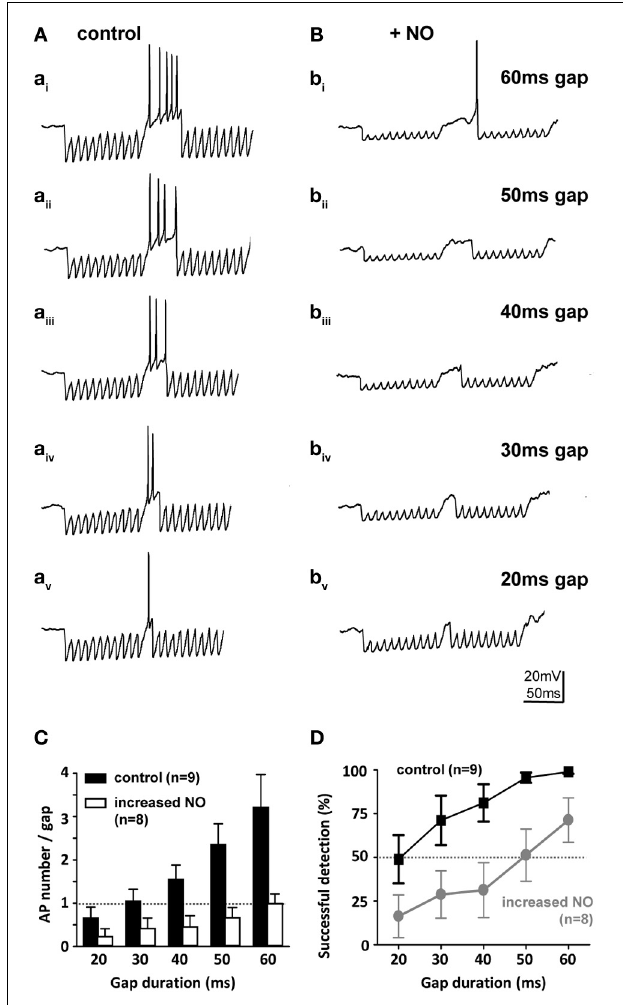
FIGURE 6 | NO suppresses IPSPs and offset firing without changing intrinsic action potential threshold. (A) Suppression of KCC2 causes synaptically-evoked IPSPs to be less hyperpolarizing. The grey bar indicates the voltage threshold for generating rebound action potentials ( − 80 . 4 ± 1 . 5mV; n = 71). (B) Glycinergic IPSPs in response to 100Hz pulse trains (indicated by the mark below the recordings) evoked rebound action potentials at the end of the train in the control condition (upper trace). Application of NO (lower trace) reduced the IPSP amplitudes and did not result in rebound firing. Stimulus artifacts were removed for clarity. (C) Current-clamp responses to hyperpolarizing and depolarizing current injections revealed similar firing patterns in the control and (D) the NO condition. (E) Input–output functions did not differ between control and NO conditions. (F) Injection of similar magnitude currents evoked similar rebound firing (or firing in response to depolarization) for both conditions, indicating no significant change in action potential threshold. ∗∗ p ≤ 0 . 01.